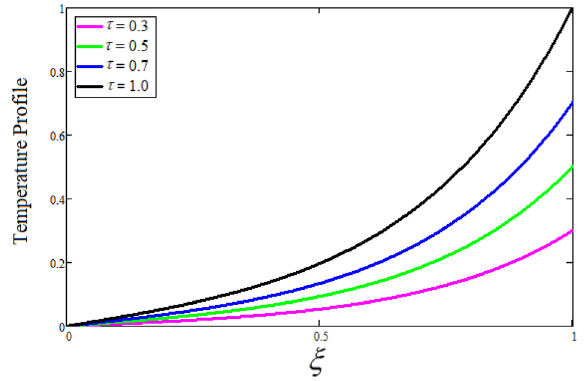
Figure 18. The consequence of t on temperature distribution. Where φ = 0.01, α = 0.5.